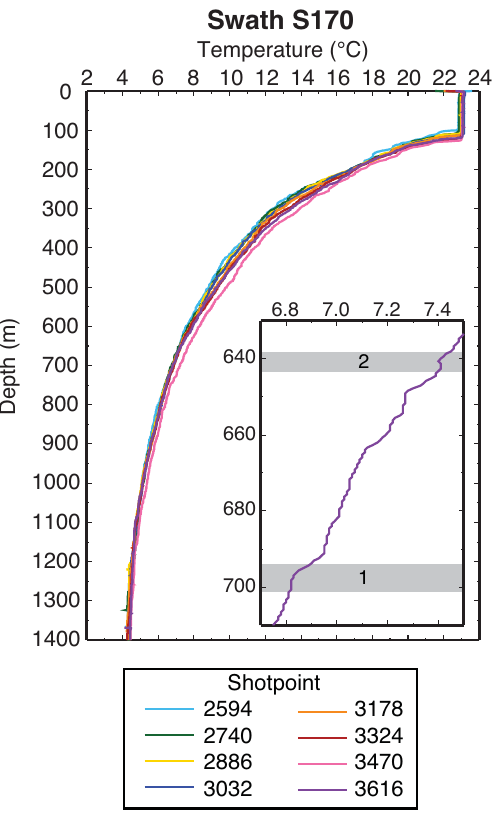
Fig. 2. Temperature profiles from XBT casts for swath S170. Inset shows blow-up of a portion of the profile for the XBT deployed nearest to the features shown in Fig. 6 (shotpoint 3616, ∼ 0.7km from features in Fig. 6). Grey bars highlight a temperature stair step (feature 1) and a small inversion (feature 2) which correspond with the reflection surfaces shown in Fig.